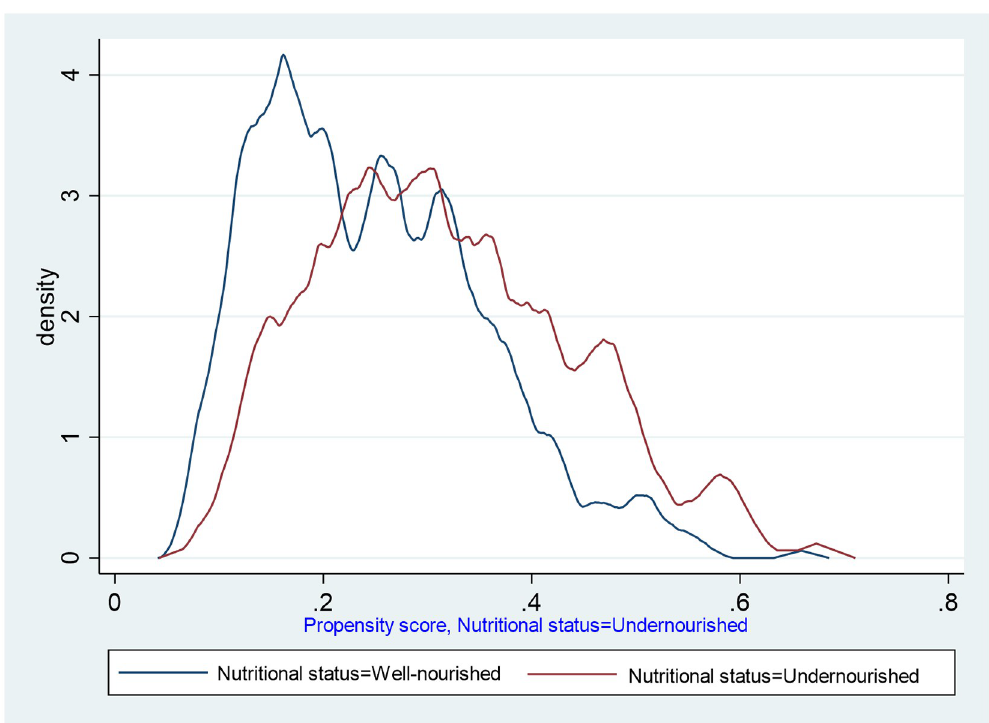
Fig 2. Propensity score distribution for overlap assumption among adults living with HIV on ART at Debre Markos Comprehensive Specialized Hospital, Northwest Ethiopia, 2021.